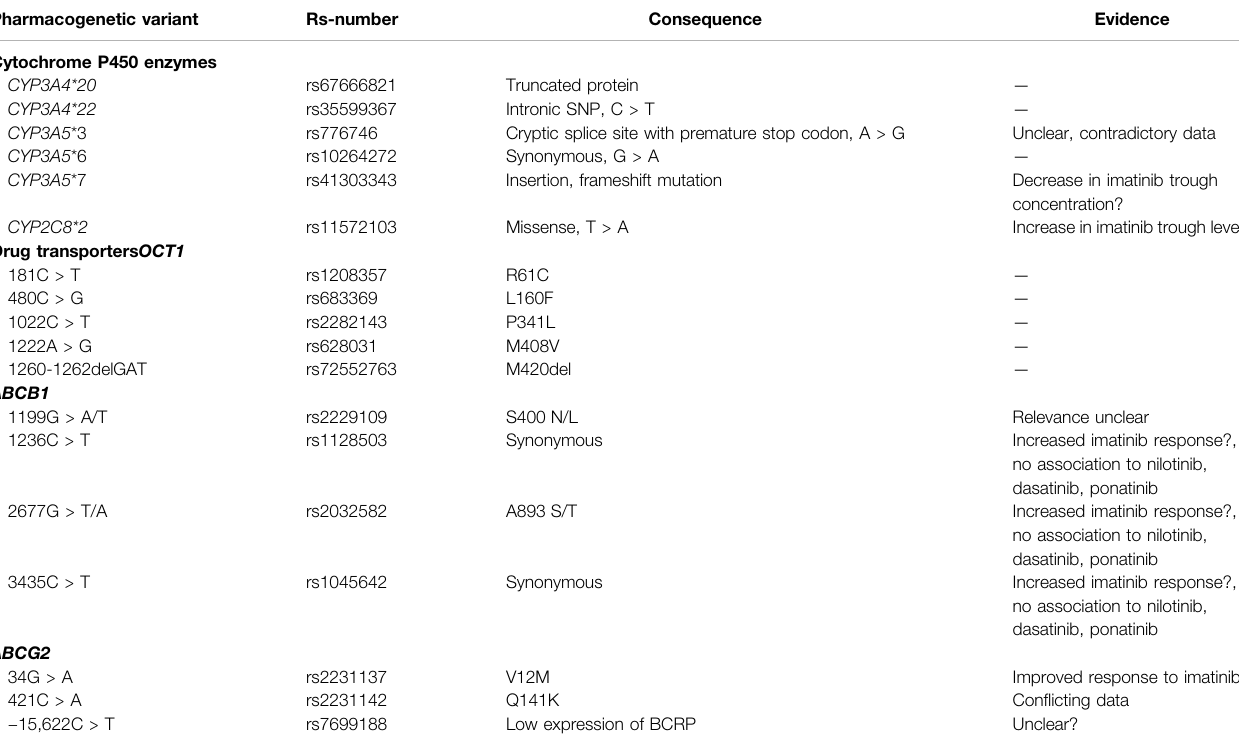
TABLE 3 | Pharmacogenetic variants in cytochrome P450 enzymes and in drug transporters and their relevance to TKI response in